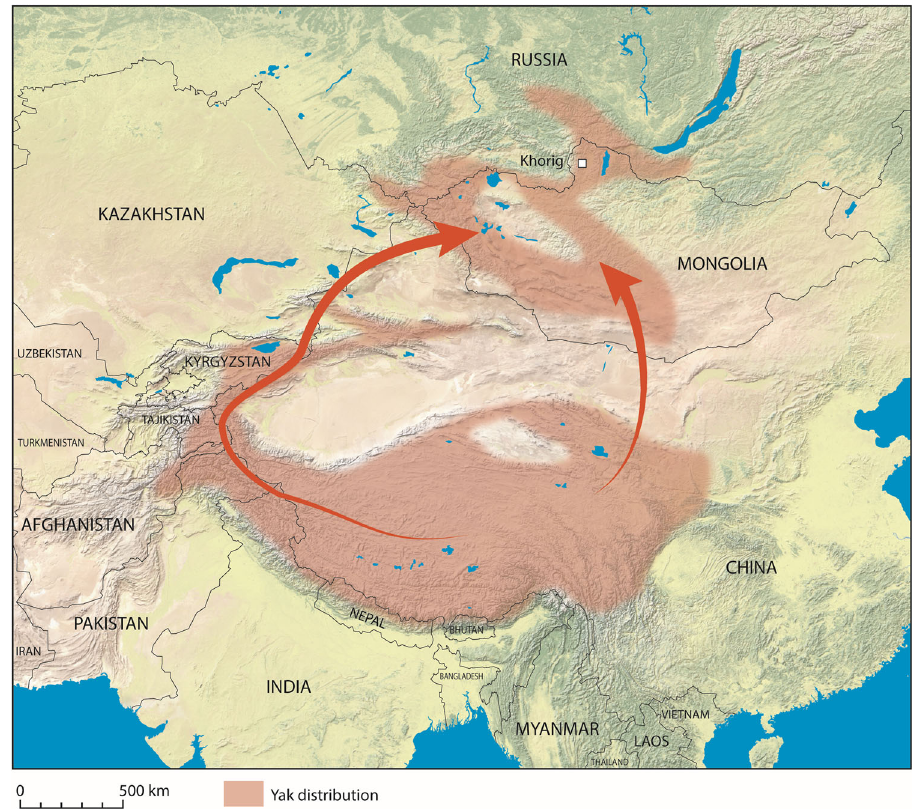
Fig. 1 Distribution of the yak across Asia during historical and modern periods. Recon fi gured from ref. 70 . Arrows suggest hypothesized pathways for the spread of domesticated yak from northern Tibet into Mongolia. This map was produced using Adobe Illustrator CC 2020 and using the Natural Early Data maps from https://www.naturalearthdta.com/downloads/ by AVM and Michelle O ’ Reilly (Graphic Designer for the MPI-SHH) and John Klausmeyer (Illustrator for the